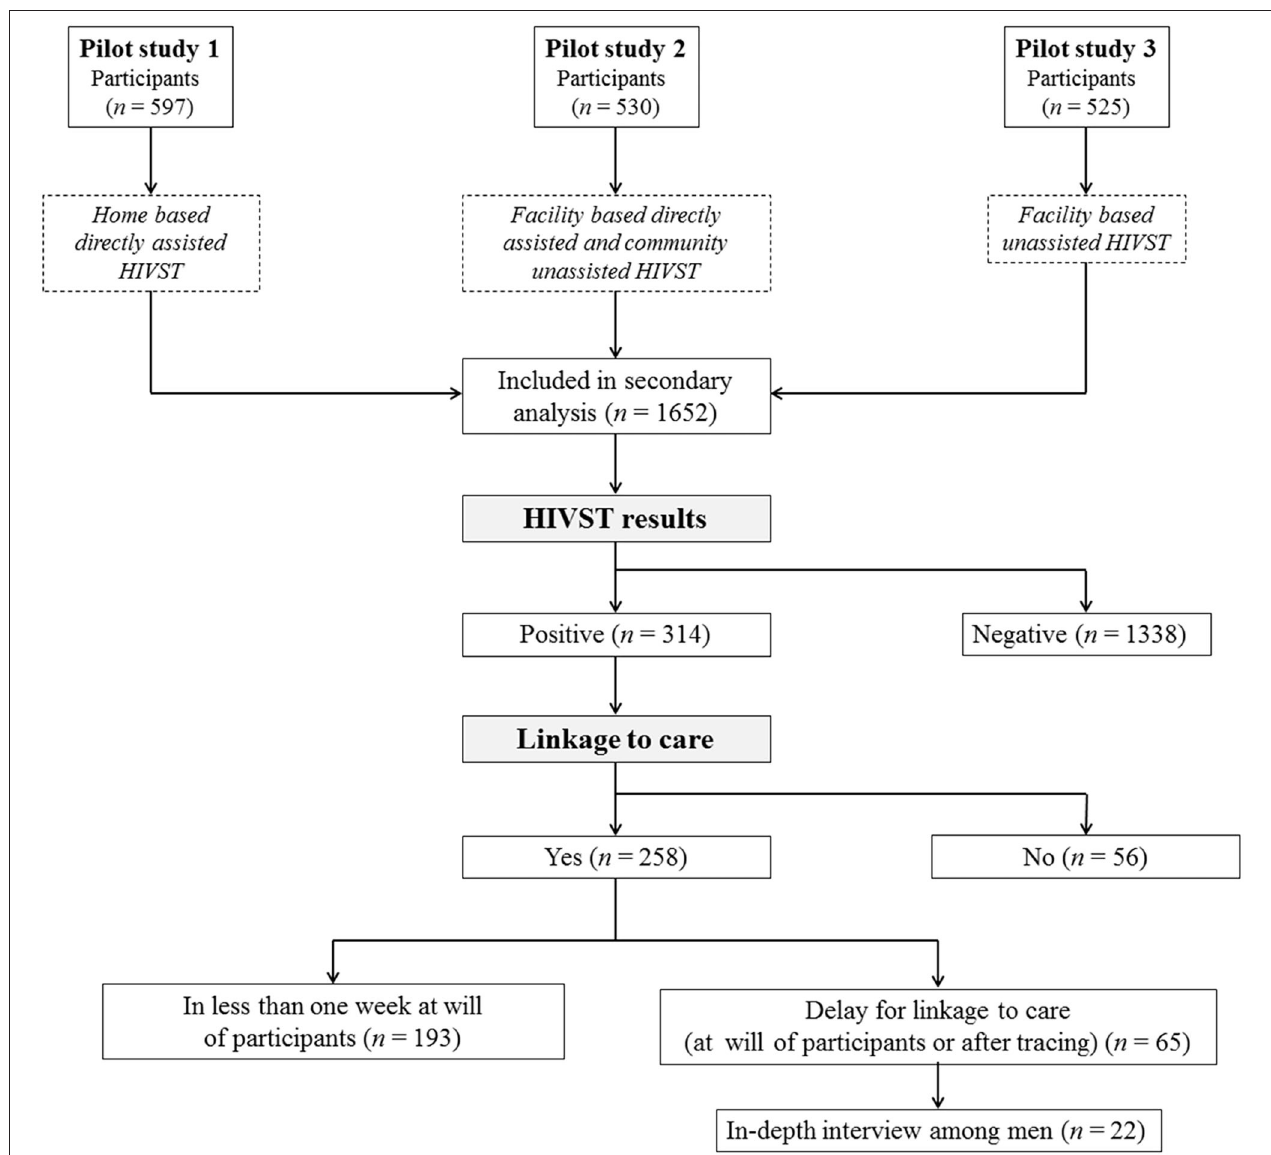
FIGURE 1 | Flowchart showing the recruitment of the study participants in pilot studies 1, 2, and 3 and follow-up for linkage to